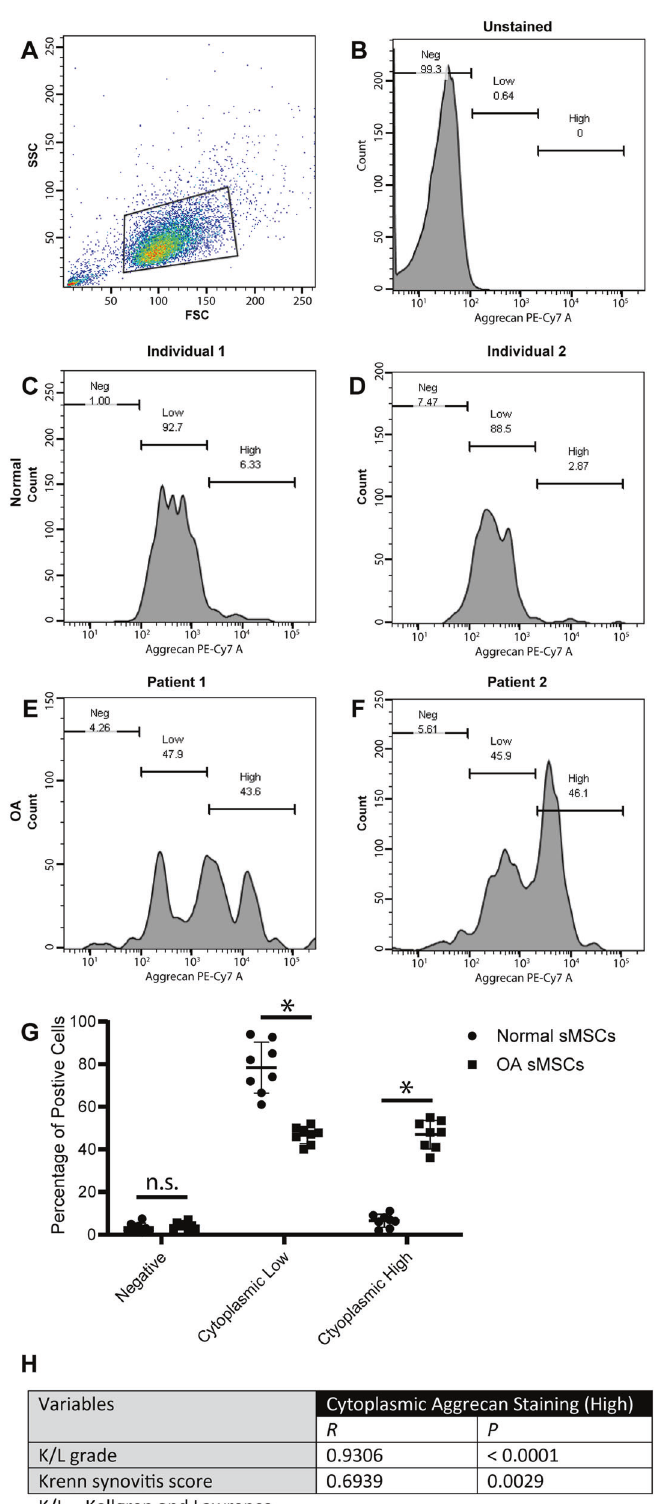
Fig. 2 Enumeration of sub-populations of synovial MPCs with abnormal aggrecan staining. Intracellular fl ow cytometry was employed to quantify cells with intense aggrecan staining adjacent to the nucleus within normal vs. OA synovial MPC populations. Overall synovial MPCs from normal and OA donors maintained a similar forward and side-scatter appearance ( A ), with unstained MPCs demonstrated little to no auto fl uorescence in the PE-Cy7 channel ( B ). Most MPCs from two representative normal individuals were positive for aggrecan (low gate: C , D ) with few cells present in the high/bright gate. However, there was an equal split between low-positive and high-positive cells in the OA MPCs tested ( E , F ), with almost all cells positive for aggrecan staining. When data from all normal ( n = 8) and OA ( n = 8) patients was quanti fi ed, ~50% of OA MPCs demonstrated this abnormal aggrecan staining, while this same staining pattern was observed in ~5% of normal MPCs ( G ). A positive correlation was observed between cytoplasmic aggrecan staining and both K/L and synovitis score ( H ). * p < 0.05. Cell Death and Disease (2022)